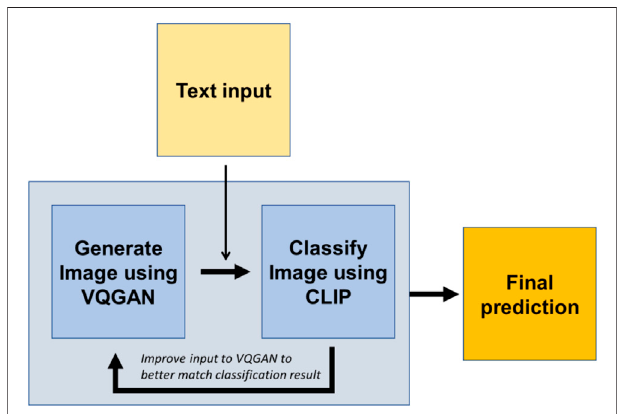
FIGURE 2 | Introduction to transformer neural networks, enabling text- to-image translation at high resolution, used here to develop microstructures for de novo architected materials, following the pairing of generator-classi fi er as suggested in (Crowson, 2021).